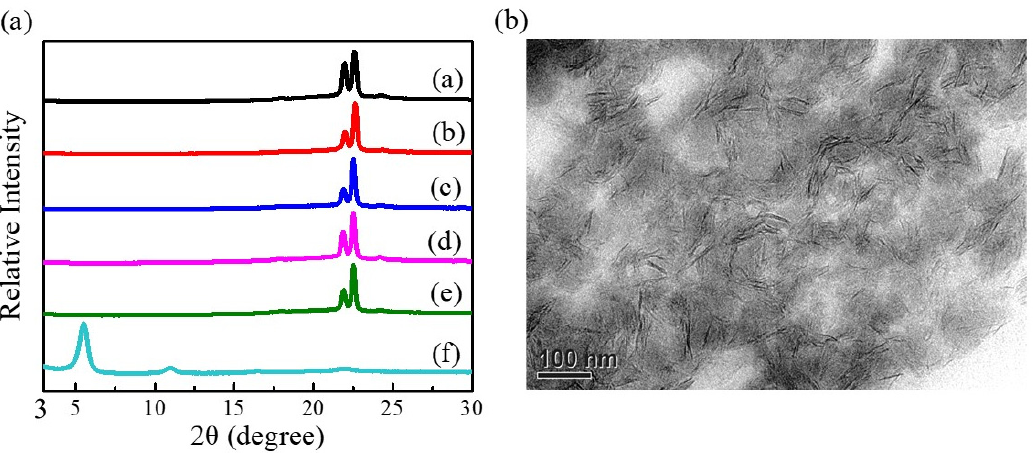
Figure 5. ( a ) WAXD patterns of g-PBAT-90 and m-LDHs, and various weight ratios of g-PBAT- 90/m-LDH nanocomposites. ( b ) TEM micrographs of 5 wt% g-PBAT-90/m-LDH